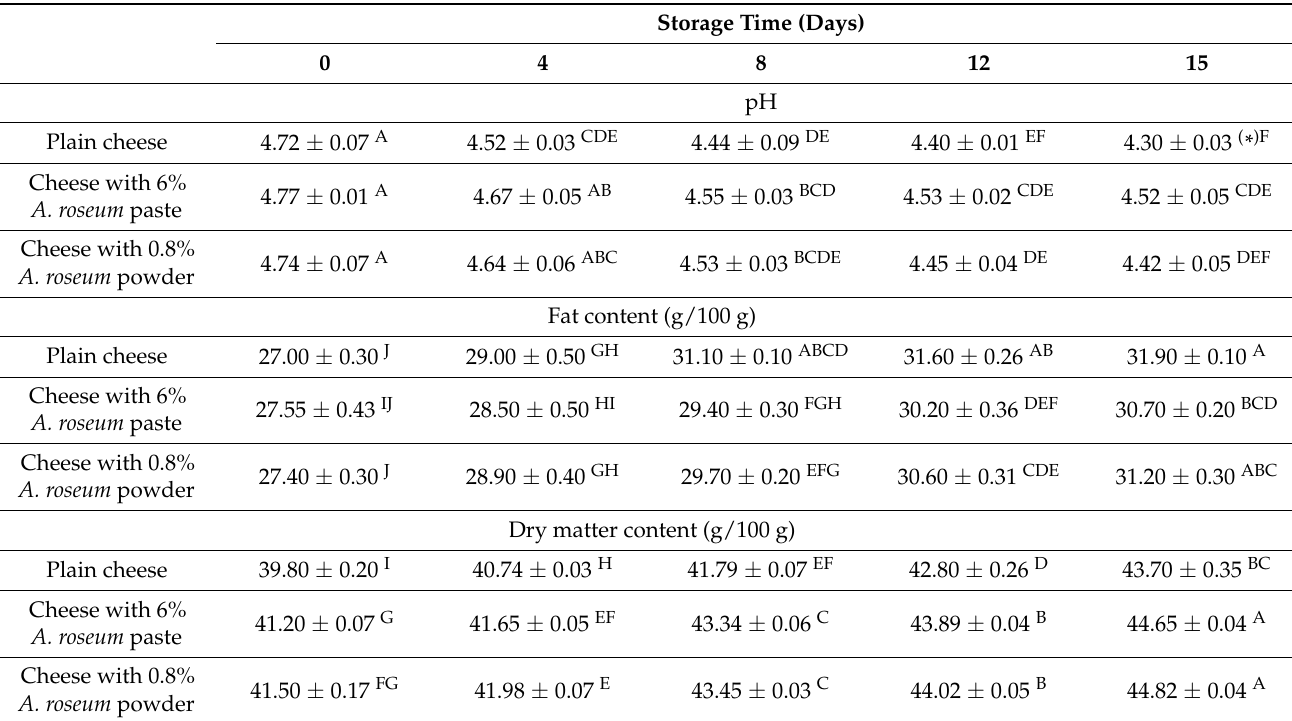
Table 2. Impact of Allium roseum supplementation on double cream cheese pH, fat and dry contents during storage at 5 ◦ C. Storage Time (Days) 0